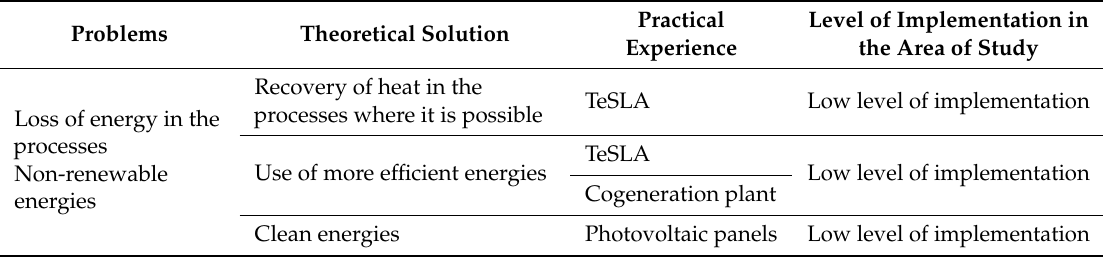
Table 10. Main solutions based on the CE for energy.